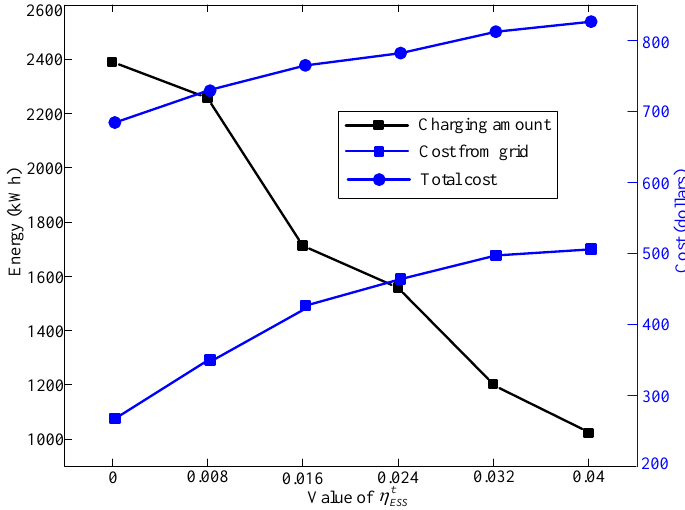
Figure 8. Charging amount of ESS and cost for different lease price of